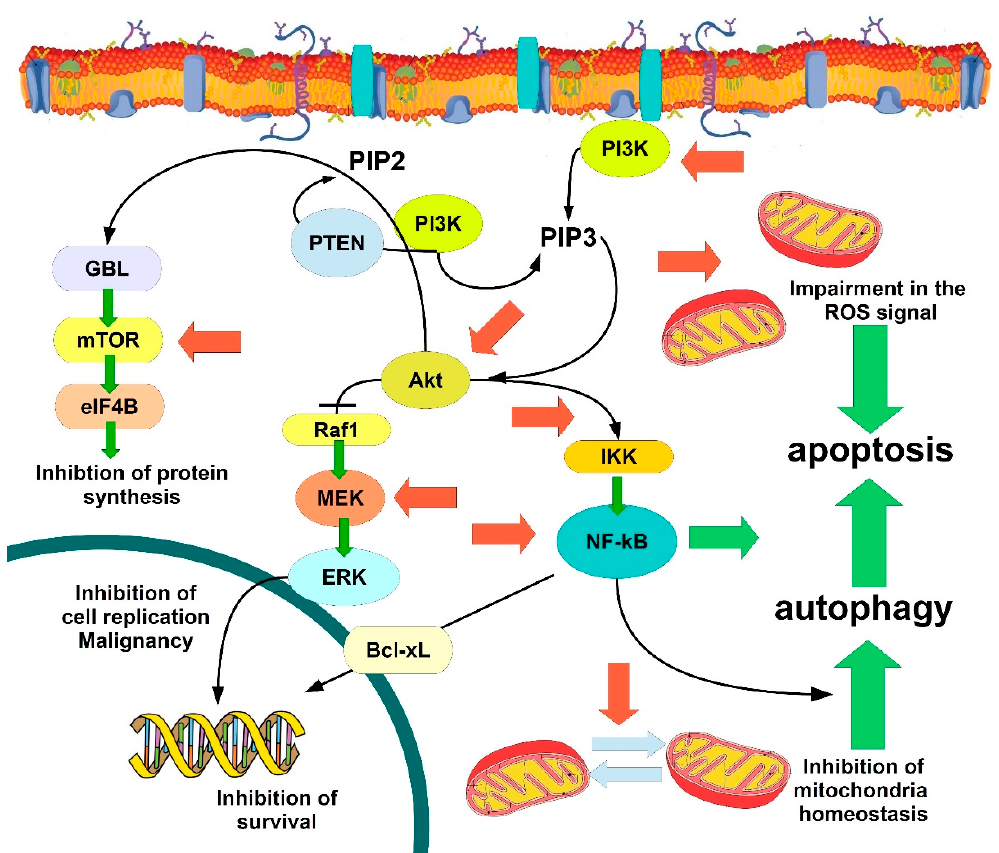
Figure 1. Cartoon showing the major signaling pathways targeted by phytochemicals in cancer. Phytochemicals principally act as inhibitors which red arrows indicate in the PI3K/Akt signaling pathway. Green arrows indicate the action promoted or activated by flavonoids, also following the inhibitory signaling cascades. For details and acronyms, see the text.